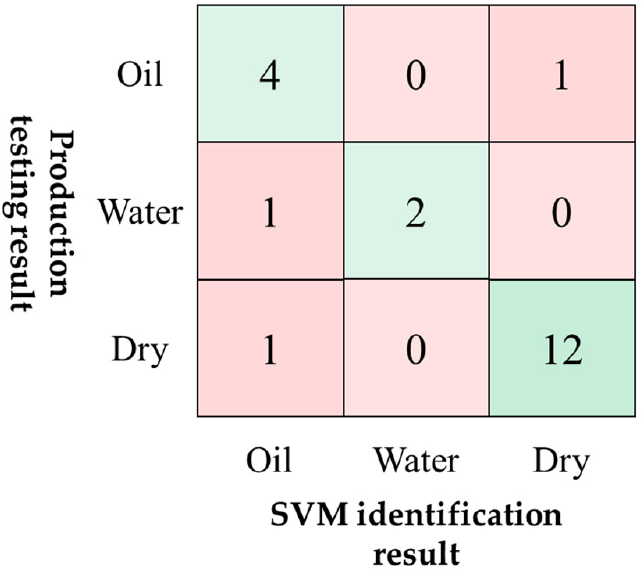
Figure 6. Confusion matrix of oil and water classification of training samples. Green means accurate prediction, pink means wrong prediction.